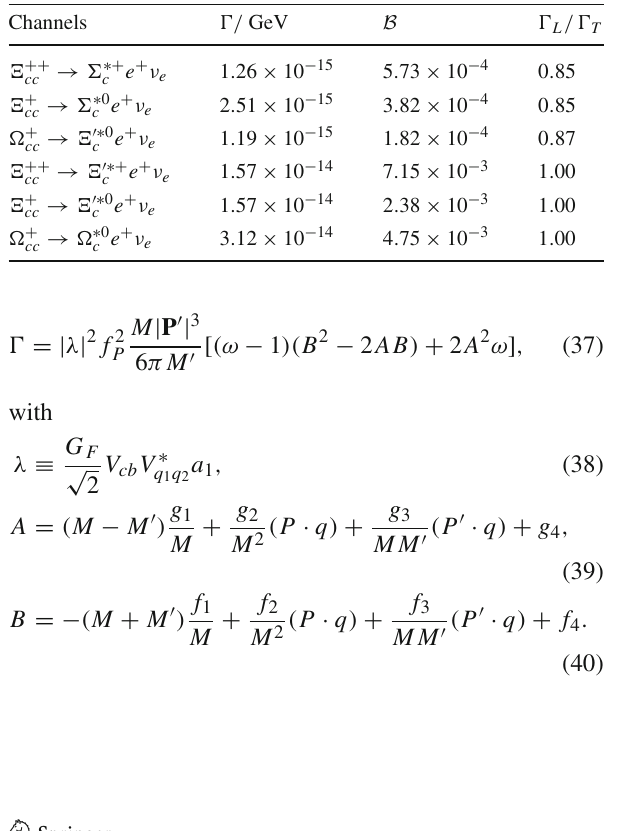
Table 10 Semileptonic decays for the cc sector